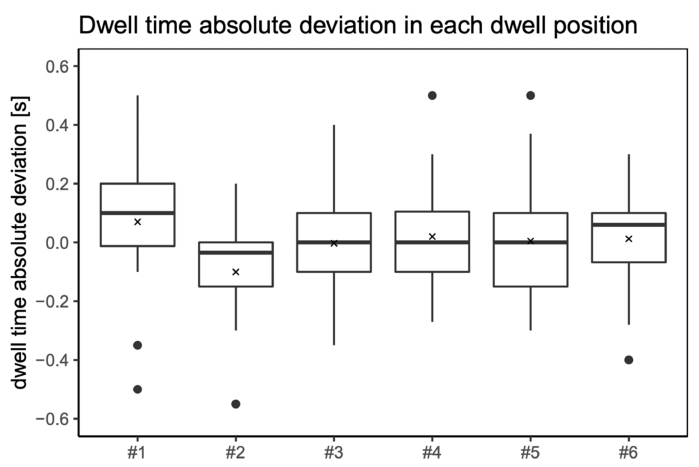
Figure 7. Box plot of the dwell time absolute deviations in each dwell position; #1 is the most distal dwell position, near the tip of the applicator. The step size used in all patients was 2.5 mm, with an inactive source position between active dwell positions: 1-3-5-7-9-11. As only 1 treatment plan used 7 dwell positions (1-3-5-7-9-11-13), the corresponding position number 13 was not included in